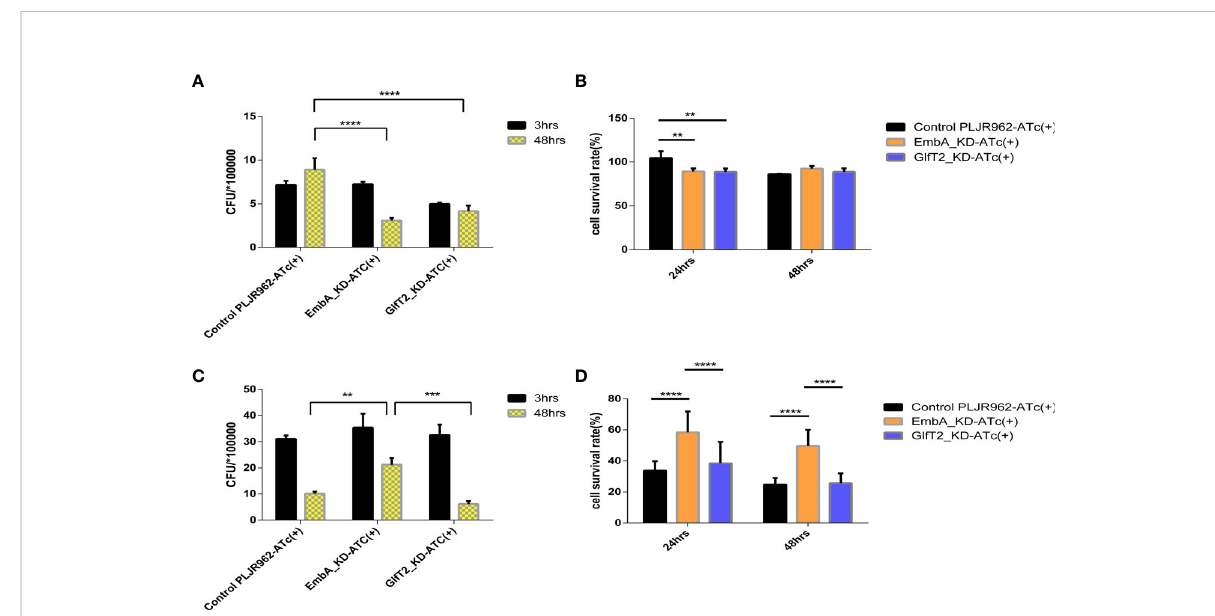
FIGURE 3 EmbA/GlfT2_KD strain-infected murine macrophage J774A.1 line. (A, B) Macrophages were infected with a multiplicity of infection (MOI) = 1 at 48-h timepoints, and cell survival rates were determined using the cell counting kit (CCK8) at 24/48 h. The cell survival rate was calculated as follows: survival rate = [(As - Ab)/(Ac - Ab)] × 100%, in which As is the absorbance of the infected well of the control of knock-down groups, Ab is the absorbance of medium-only well without added cells, and Ac is the absorbance of uninfected cell wells. (C, D) The macrophages were infected with a MOI = 5 at 48-h timepoints, and the cell survival rate was determined by CCK8 at 24/48 h. (A – D) Data processing is homogenized, and data are plotted as mean ± SD. Two-way ANOVA tests are used for all signi fi cance analysis here: ** P < 0.01, ** P < 0.01, *** P < 0.001, and **** P <